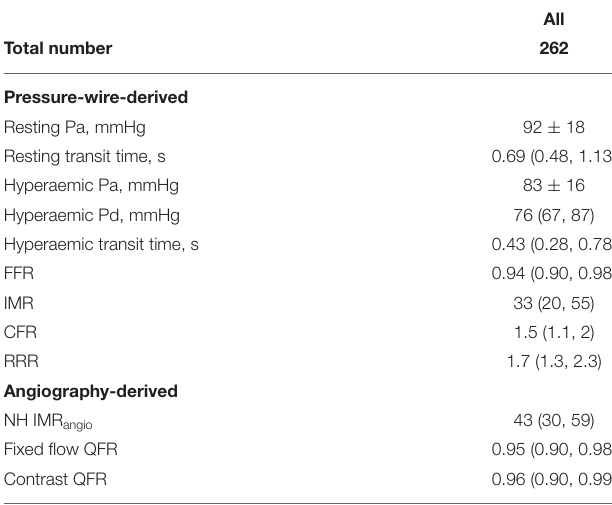
TABLE 2 | Post PCI pressure-wire- and angiography-derived coronary physiology